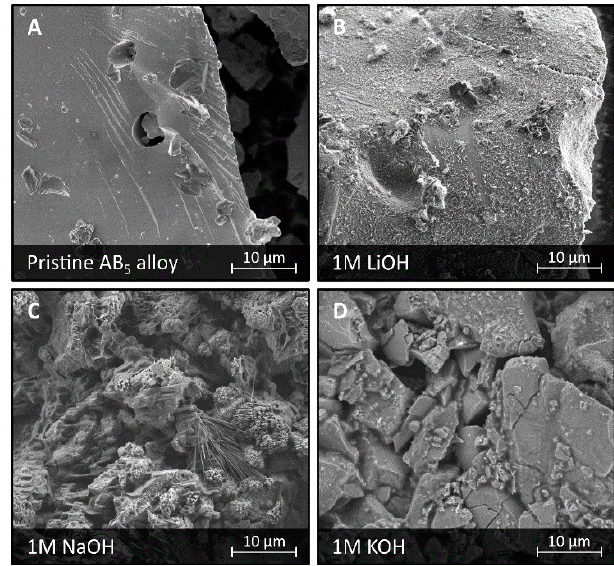
Figure 1. SEM images of a surface of LaMm-Ni 4.1 Al 0.3 Mn 0.4 Co 0.45 alloy not subjected to any treatment ( A ), and after electrochemical treatment in 1 M LiOH ( B ), 1 M NaOH ( C ), and 1 M KOH ( D ).